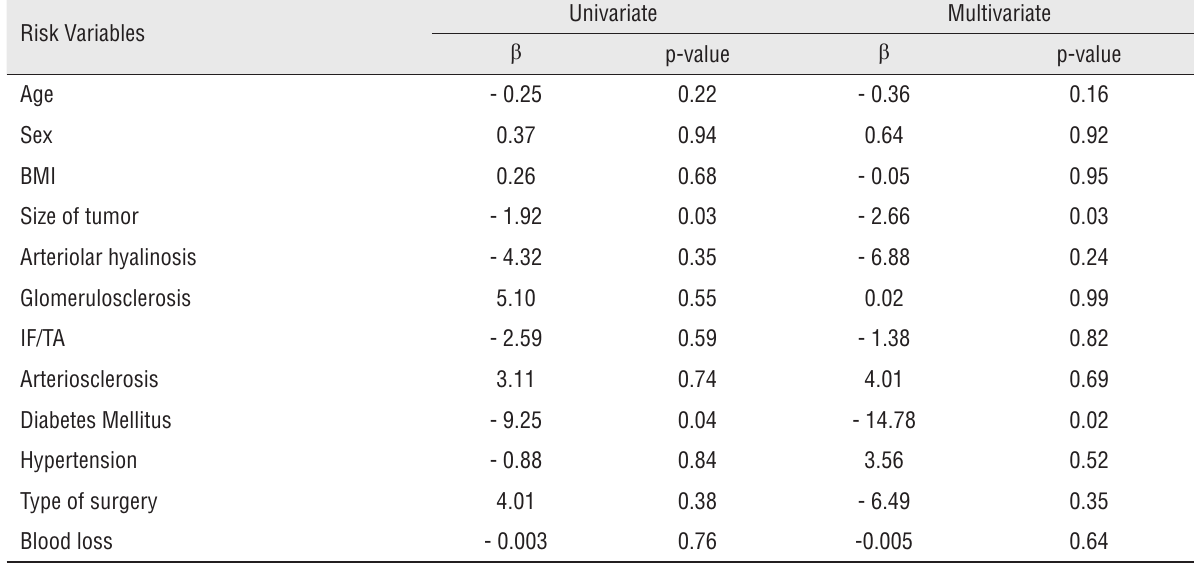
Table 3 - univariate and Multivariate analysis with percentage change in eGfR as